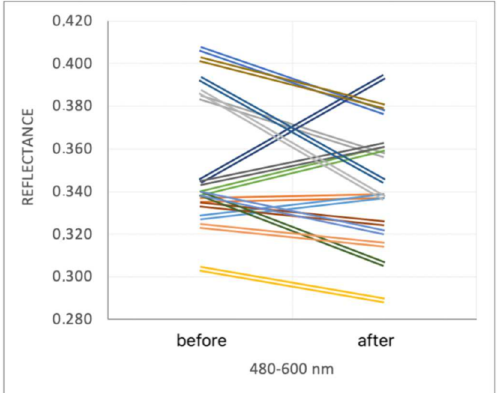
Figure 5. Average results of 3 reflectance measurements at a wavelength of 480–600 nm in every woman undergoing microdermabrasion, before and after the